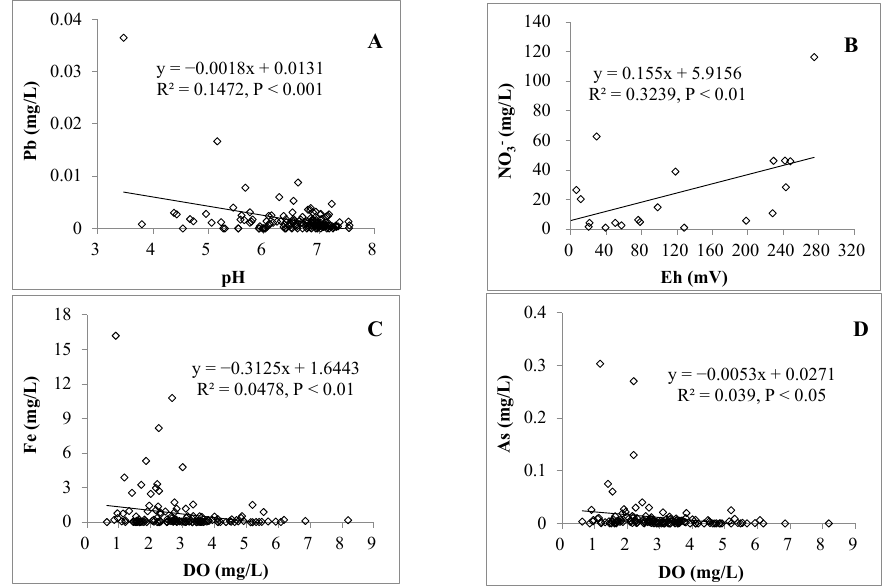
Figure 6. Relationships between concentrations of groundwater chemicals in the coastal alluvial aquifer of the Pearl River Delta. ( A ) Pb and pH; ( B ) NO 3 − and Eh in agricultural areas; ( C ) Fe and DO; ( D ) As and DO.